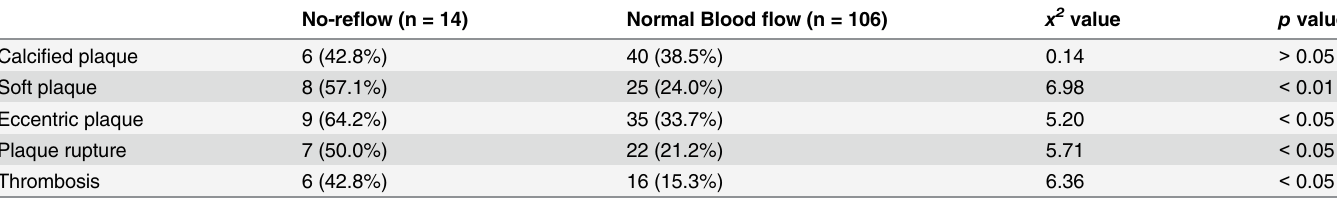
Table 3. Comparison of coronary lesions traits in IVUS between the 2